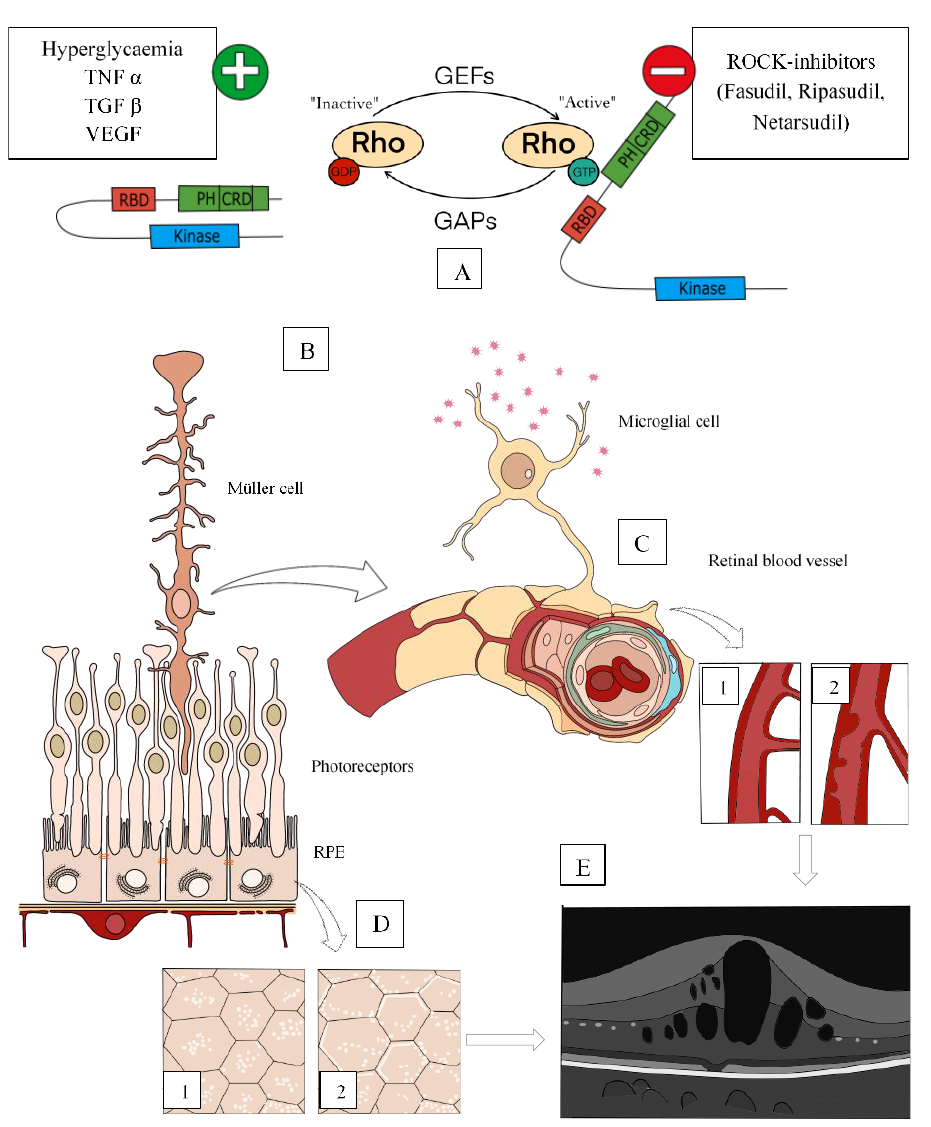
Figure 2. Rho activation and participation in DMO pathways. ( A ) In response to hyperglycaemia and in the presence of cytokines (TNF- α ) and growth factors, such as VEGF and TGF- β , the activation of Rho by guanine exchange factors (GEF) is produced. GTPase-activating proteins (GAP) stimulate endogenous GTPase activity, facilitating GTP hydrolysis in GDP and inactivating Rho. ( B ) On the left side, a normal-structured external retina is represented, and on the right side, an anomalous neurovascular junction in DMO. Rho-kinase signalling pathways are upregulated in Müller glial cells in response to hypoxia and oxidative stress and take part in DMO pathogenesis. ( C ) Representation of vessels from a normal retina ( C1 ) and a diabetic one ( C2 ). within inner-retinal vessels, rho pathways are involved in retinal vasoconstriction, endoluminal blebbing, endothelial impairment and leukostasis in response to an increased inflammation state and ICAM-1 and VCAM-1 hyperproduction in DMO. ( D ) At RPE level, ROCK participates in bleb formation and cellular remodulation and produces polarization and cell adhesion changes in response to hyperglycaemia modifying outer-BRB. In normal RPE cells, ROCK-1 is cytoplasmic ( D1 ), but in diabetic conditions, it is recruited to the membrane ( D2 ). ( E ) Representation of an OCT image showing a cystoid DMO with hyperreflective dots as a result of the mentioned patho-physiological abnormalities. Rho kinase and ROCK pathways. The ROCK molecular structure consists of three parts, the N-terminal kinase region, that catalyzes the phosphorylation/dephosphorylation of a series of downstream substrates; a coiled-coil region, in which the Rho-binding domain (RBD) regulates the activation signal of Rho transduction; and a C-terminal region terminal, which contains a pleckstrin homology (PH) and cysteine-rich domain (CRD). This region contains a self-inhibiting region that interacts with the kinase domain to inhibit ROCK activity [106–109].